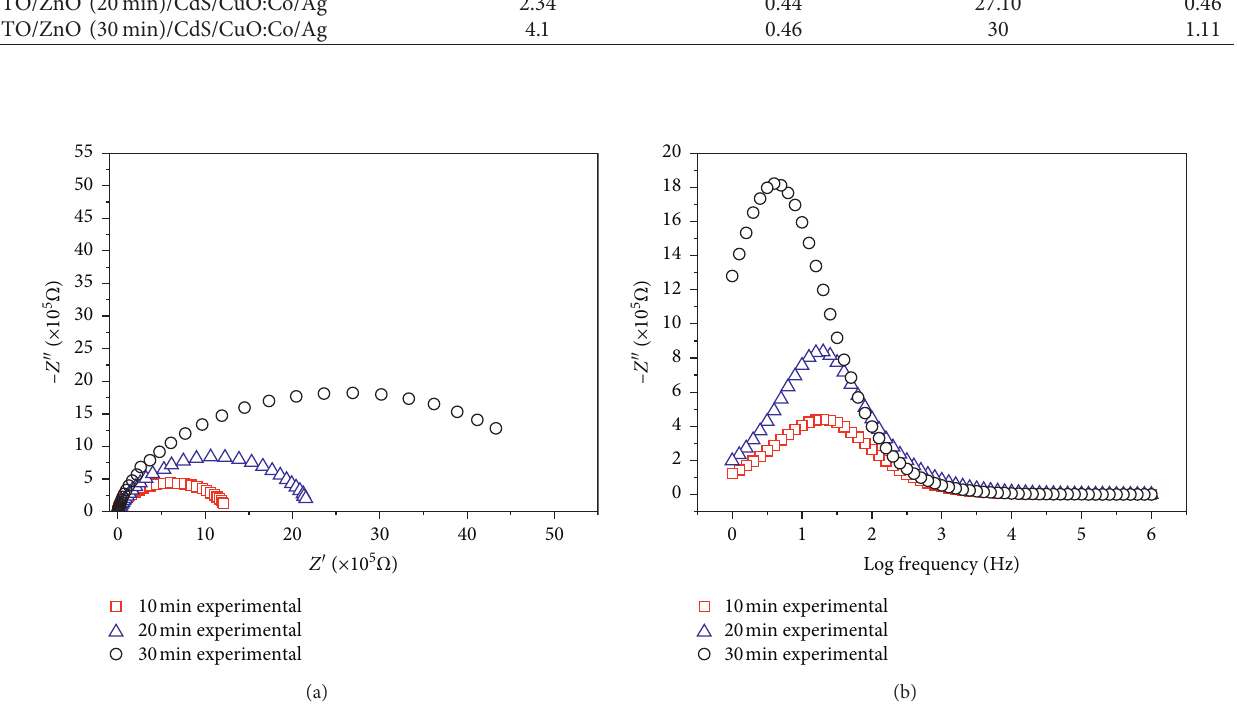
Figure 3: (a) Nyquist plot and (b) bode plots in the frequency range from 1Hz to 1MHz of heterojunction at different time periods of deposition of ZnO.